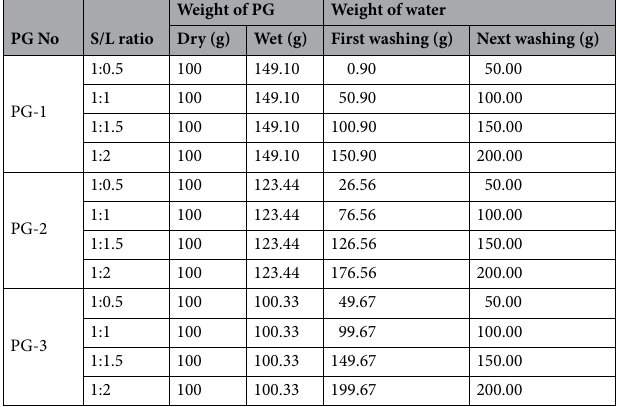
Table 2. Mix design of water washing pretreatment of PG samples.